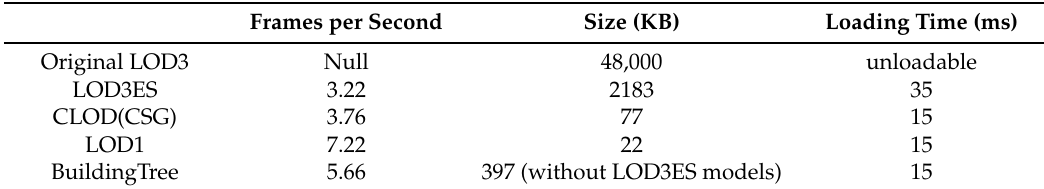
Table 1. Test results of the generalized 3D city